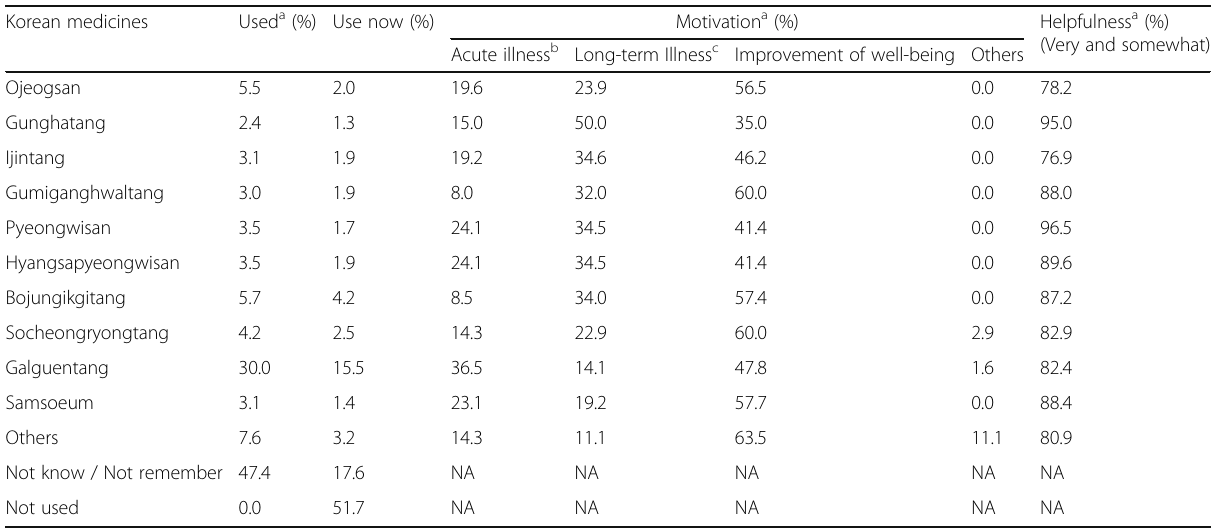
Table 7 Use of Korean medicines Korean